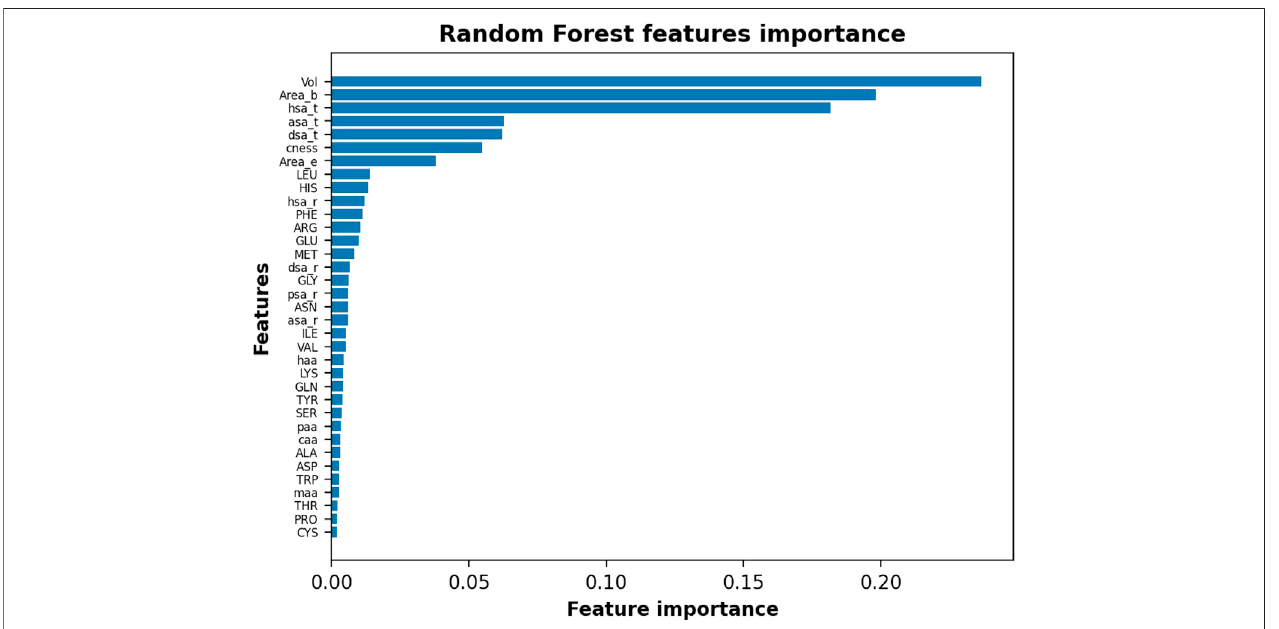
FIGURE12| RandomForestfeaturesimportanceinthedescendingorderbyassigning expost labelstotheIVDDpredictions.Resultsshownarewithouthydrogen atoms; similar results are obtained with hydrogen atoms.